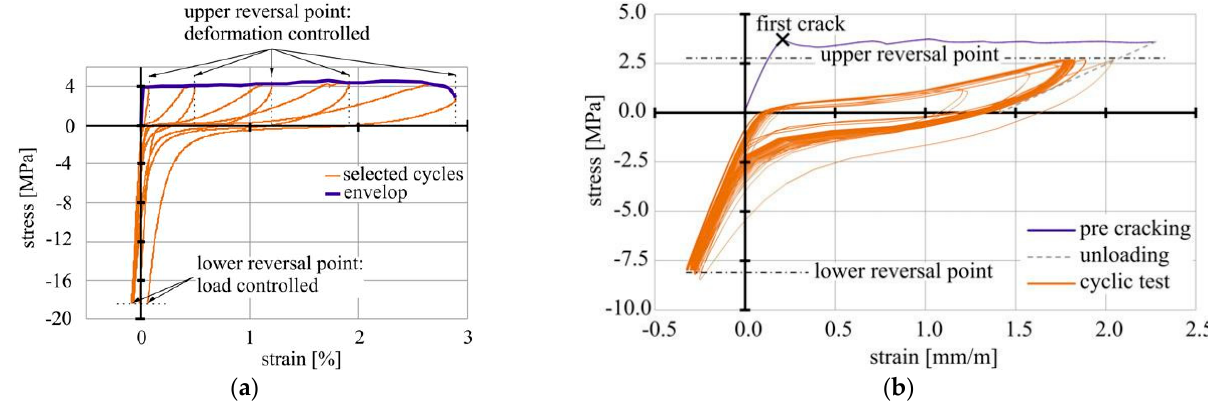
Figure 4. Schematic presentation of the testing regimes [7]: ( a ) deformation-controlled regime; ( b ) load-controlled regime.